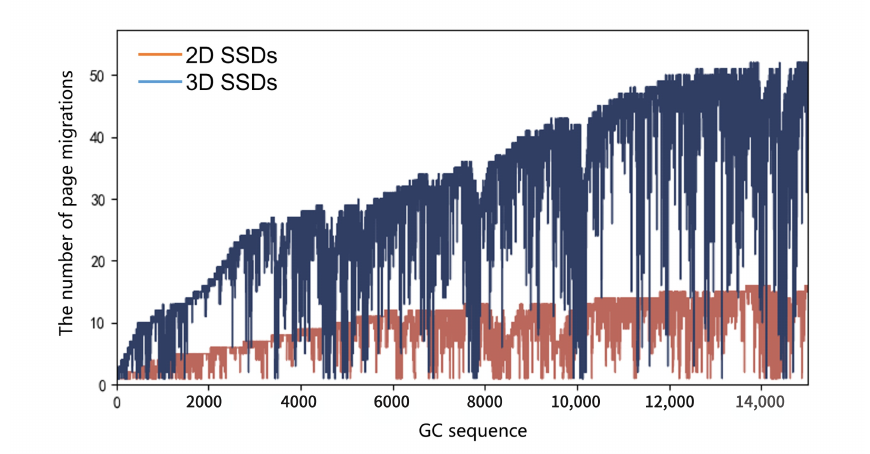
Figure 5. The number of page migrations in garbage collection. The abscissa in the figure is the serial number of GC, and the ordinate represents the number of page migrations in the current GC. The number of GC page migrations is significantly higher in 3D SSDs ( blue broken line ) than in 2D SSDs ( red broken line ).